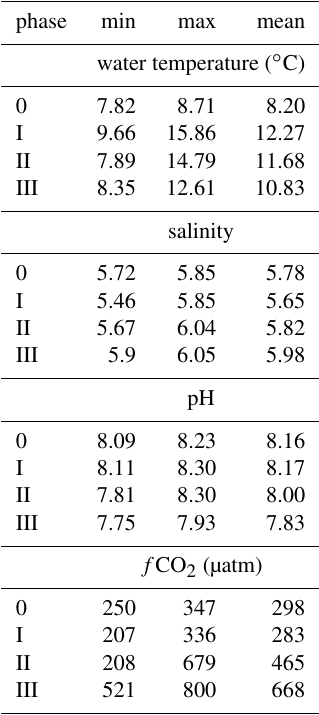
Table 1. Minimum, maximum and mean values of hydrographical parameters and f CO 2 for the different phases in the fjord. Temper- atures in the mesocosms were identical with those in surrounding fjord